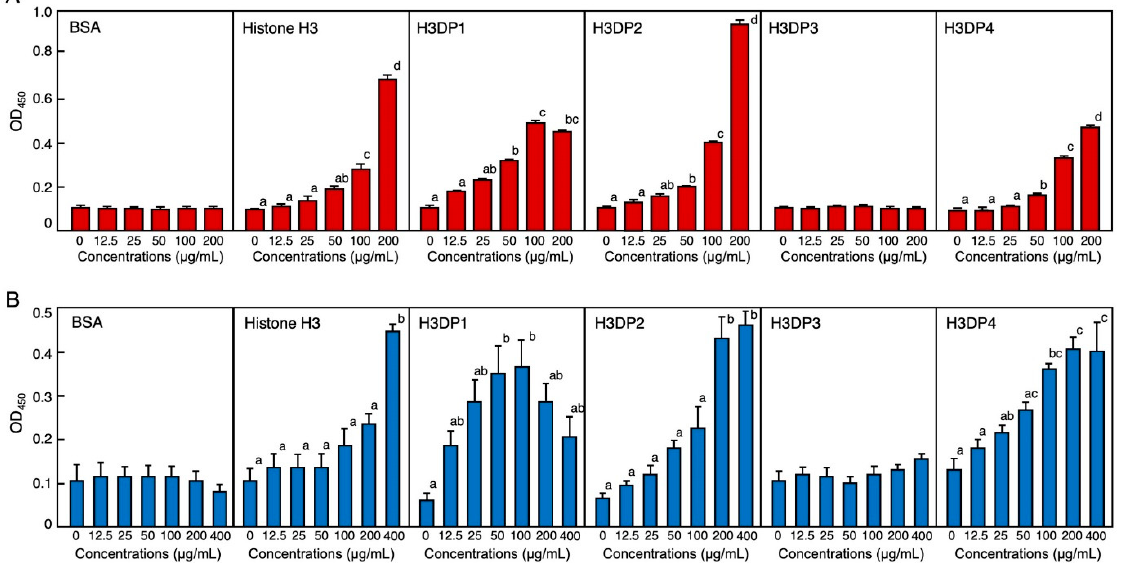
Figure 7. Evaluation of binding abilities of bovine serum albumin (BSA), histone H3, H3DP1, H3DP2, H3DP3, and H3DP4 to the bacterial endotoxins lipopolysaccharide (LPS) (( A ); red columns) and lipoteichoic acid (LTA) (( B ); blue columns) using enzyme-linked endotoxin binding assay (ELEBA). Serially diluted proteins or peptides were individually coated onto 96-well microplates and incubated with biotin-LPS or biotin-LTA for 4 h at 25 °C. The peptides-bound biotin-LPS or biotin-LTA were detected by incubation with HRP-labeled streptavidin followed by incubation with the ELISA POD substrate in the TMB solution. The reaction products were measured at 450 nm. Each column and vertical bar represent the mean and standard error of the mean, respectively ( n = 4). In each panel, values with the same letters are not significantly different ( p ≥